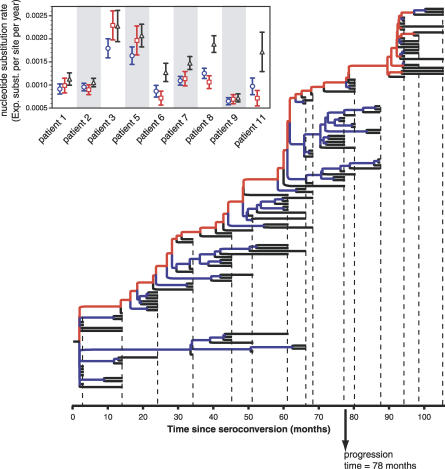
Internal, Backbone, and External Branches in a Within-Host HIV Genealogy, and Mean Nucleotide Substitution Rates for These Branches in Nine Longitudinally Sampled HIV-1 PatientsTo avoid the influence of deleterious mutations segregating to external branches in intrapatient HIV genealogies, we estimate mean substitution rates for the set of internal and backbone branches. These branch sets are depicted in color in the maximum a posteriori tree for “patient 1” obtained by Bayesian relaxed-clock inference [26] (backbone, red; internal, blue; external, black). The backbone represents the central trunk of trees shaped by rapid lineage turnover and can be defined phylogenetically (see Methods). Note that the set of internal branches also includes the backbone branches. Samples for each time point are indicated by the dotted line. Mean nucleotide substitution rates and their standard deviations on internal, external, and backbone branches are shown for all longitudinally sampled HIV-1 patients. The consistently higher substitution rate on external branches might be indicative of higher mutation load on these branches.